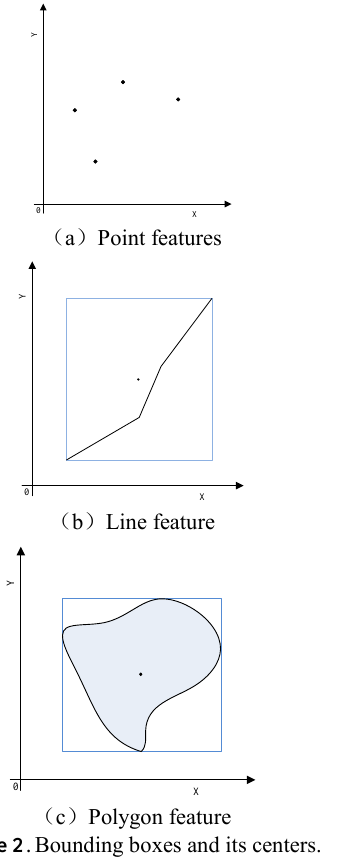
Figure 2 . Bounding boxes and its centers.